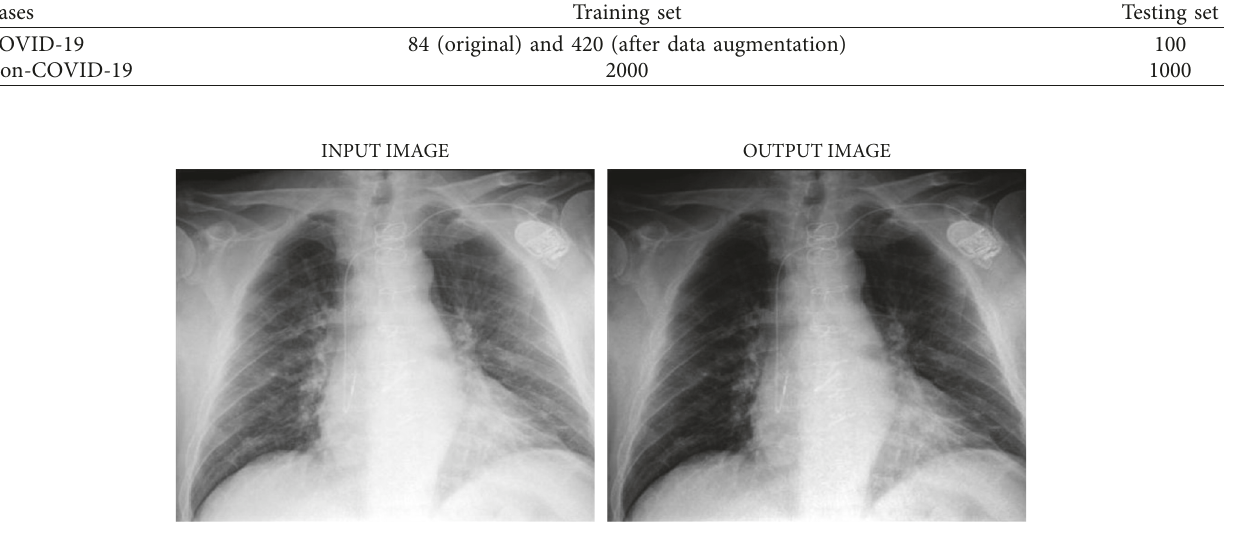
Figure 2: Balance contrast enhancement technique (BCET) output. Table 2: GLCM features. Table 3: Shape-based features.